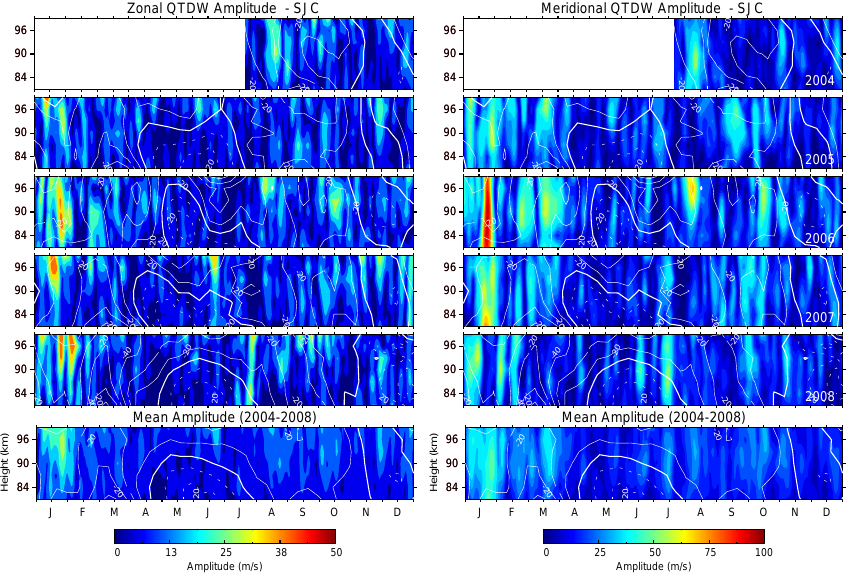
Figure 3. The time-height cross section of the QTDW amplitudes and composite-year QTDW amplitudes over Cariri for zonal (left hand plots) and meridional (right hand plots) components, for the years 2004 to 2008. Monthly mean eastward (dotted) and westward (solid) winds also are plotted as open white contours.